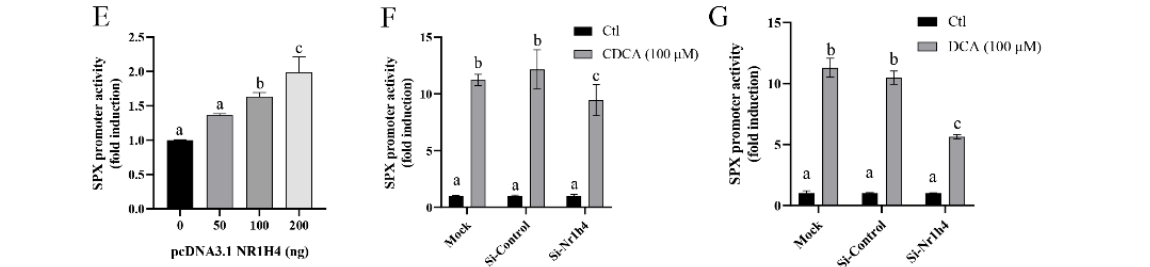
Figure 3. The effect of bile acid on SPX promoter through membrane receptor (TGR5) and nuclear receptor FXR. ( A ) Time course analysis on the effect of TGR5 Receptor Agonist (10 µ M, 6–48 h) on SPX promoter activity in SMMC7721 cells. ( B ) Concentration gradient analysis on the effect of TGR5 Receptor Agonist (3–30 µ M, 24 h) on SPX promoter activity in SMMC7721 cells. ( C ) SMMC7721 cells transfected with SPX promoter treated by CDCA (100 µ M, 24 h) in the presence or absence of siRNA for gpbar1 (30 ng/well) (TGR5) or siRNA control. ( D ) SMMC7721 cells transfected with SPX promoter treated by DCA (100 µ M, 24 h) in the presence or absence of siRNA for gpbar1 (30 ng/well) (TGR5) or siRNA control. ( E ) Concentration gradient analysis on the effect of pcDNA3.1 NR1H4 (50–200 ng) on SPX promoter activity in SMMC7721 cells. ( F ) SMMC7721 cells transfected with SPX promoter treated by CDCA (100 µ M, 24 h) in the presence or absence of siRNA for NR1H4 (30 ng/well) (FXR) or siRNA control. ( G ) SMMC7721 cells transfected with SPX promoter treated by DCA (100 µ M, 24 h) in the presence or absence of siRNA for NR1H4 (30 ng/well) (FXR) or siRNA control. The groups denoted by different letters represent a significant difference at p < 0.05.